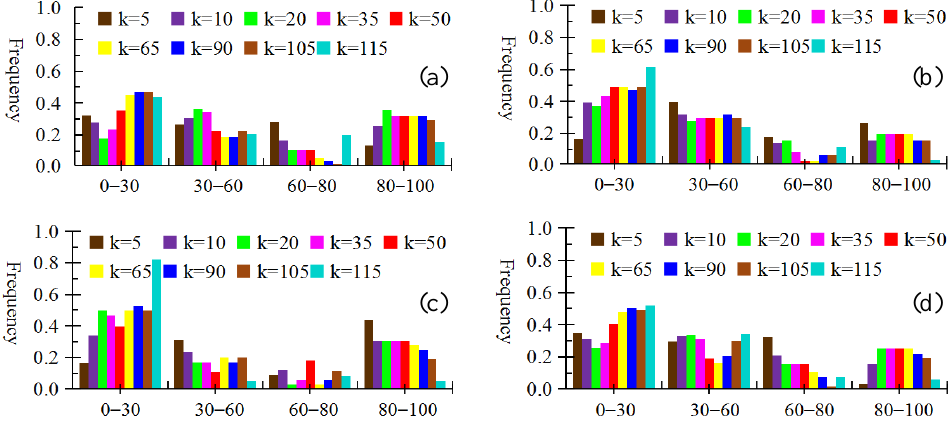
Figure 13. Frequency distribution of outlier detection for four types of surface objects. ( a ) Cultivated land, ( b ) forest, ( c ) buildings, and ( d ) water bodies. Note: Transverse axis denotes FSOI values.